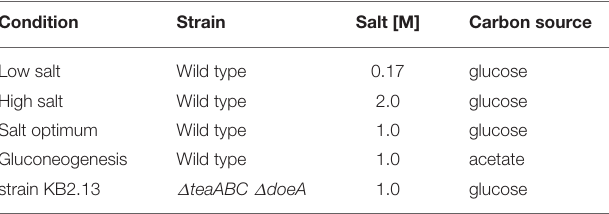
TABLE 1 | Summary of all different combinations of strains, carbon sources and salt concentrations used for the RNA sequencing.